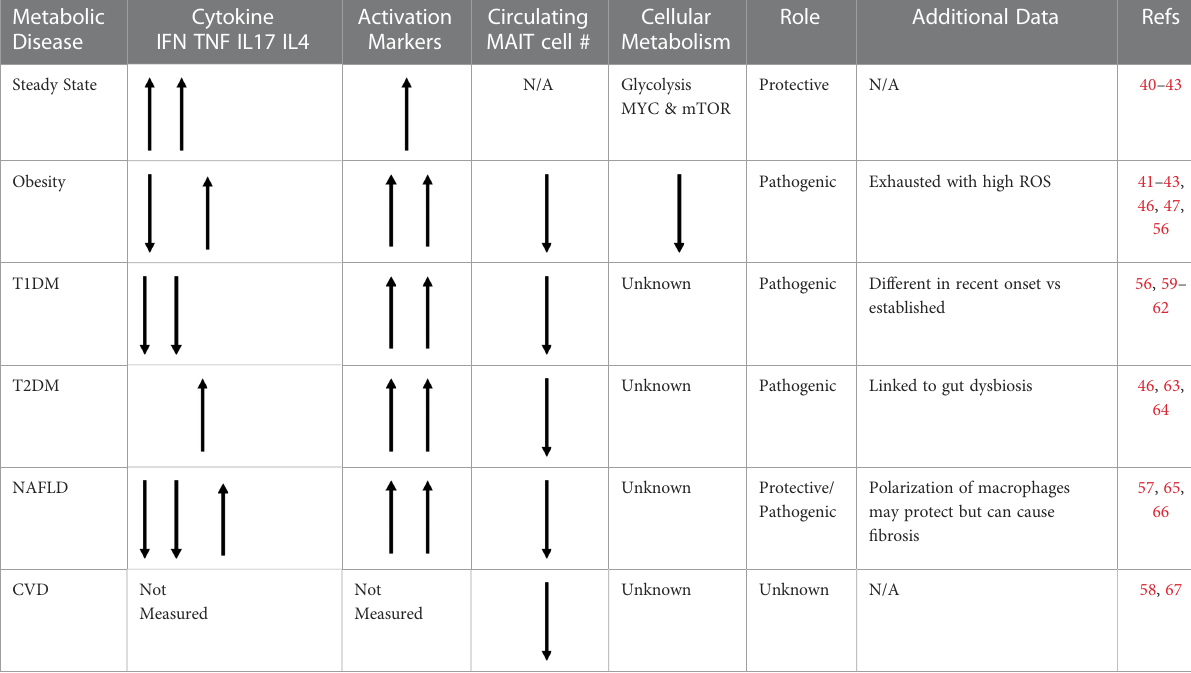
TABLE 1 Table outlining the phenotype, frequency and role of MAIT cells in various metabolic diseaes. Metabolic